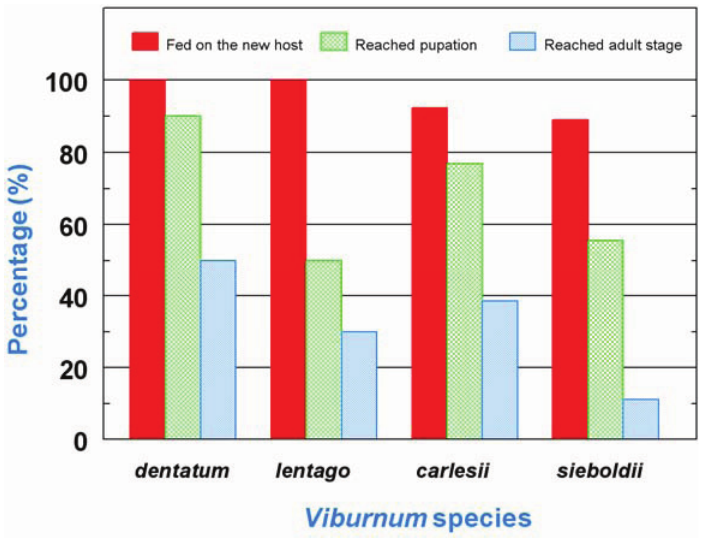
Figure 1. Development of P. viburni 3rd instar larvae after transfer from an optimal host species ( V. dentatum , n = 10) to the same host or to a suboptimal host ( V. lentago , n = 10; V. carlesii , n = 13; V. sieboldii , n = 9). The mean duration of development until adult emergence was 30.0 ± 2.4